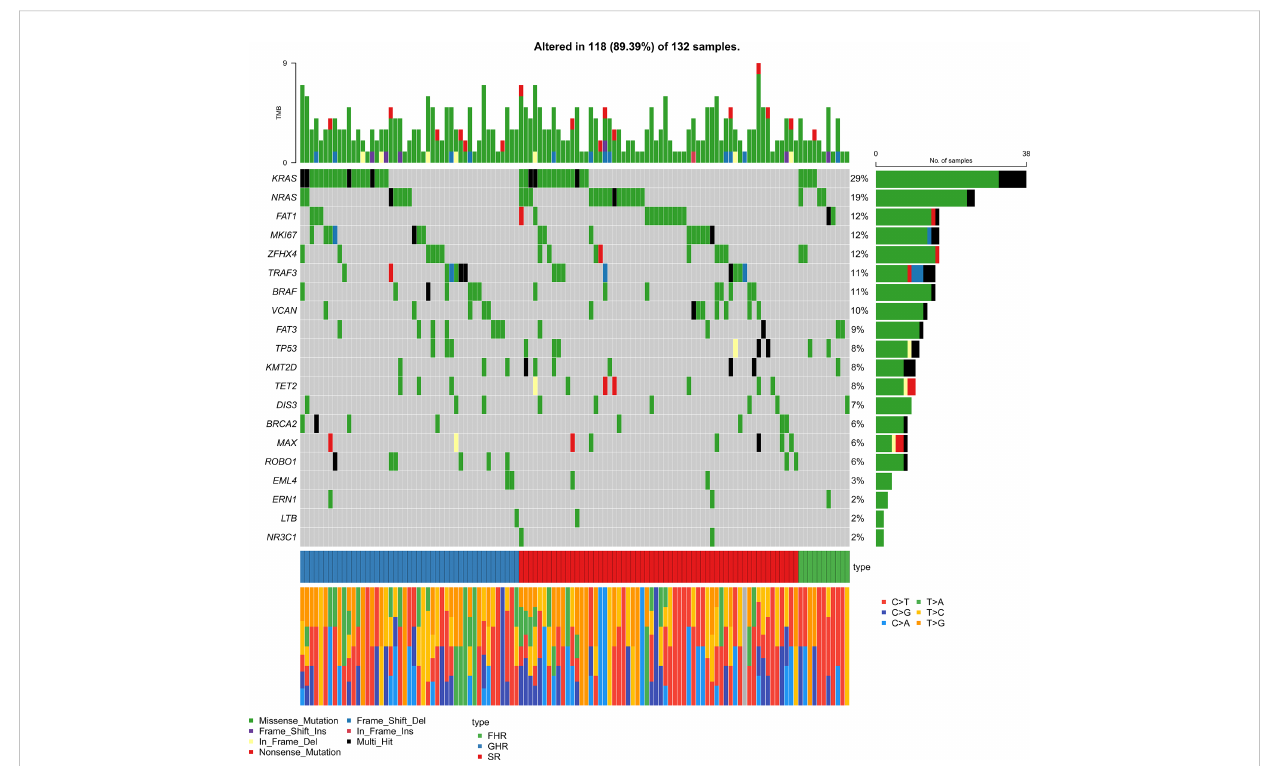
FIGURE 3 Composite heat map combining FISH detection and gene